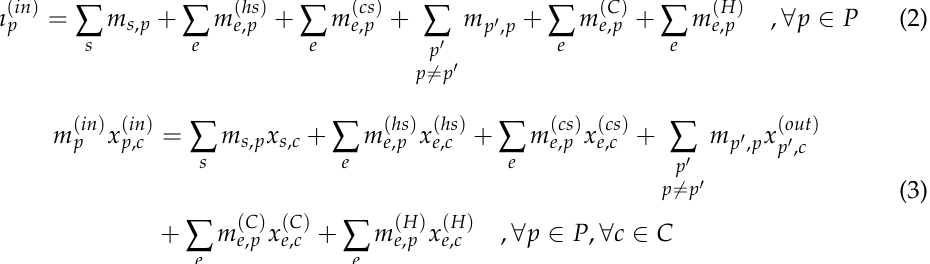
The heat balance of the process unit p mixer is given by Equation